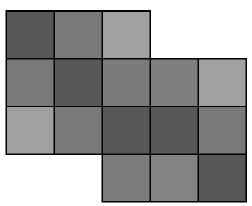
Figure.7 the pixels after Gaussian filter